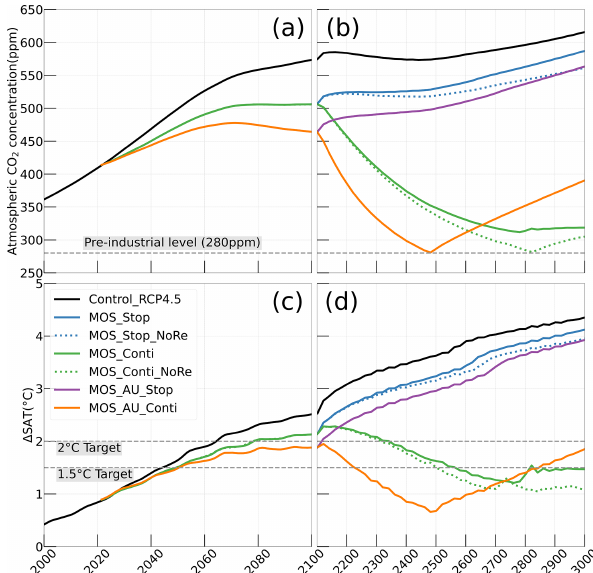
Figure 4. Simulations of ( a , b ) annual global mean atmospheric CO 2 concentration and ( c , d ) surface-averaged temperature relative to the pre-industrial (average of year 1850 to year 1900) level of 13.18 ◦ C ( (cid:49) SAT). Under RCP 4.5 scenario, MOS reaches the 2 ◦ C target in conjunction with AU, while the 1.5 ◦ C cannot be met in all MOS simulations. Note that MOS is terminated whenever pre- industrial concentrations of atmospheric CO 2 are reached, as seen for MOS_AU_Conti (solid orange) and MOS_Conti_NoRe (dotted blue) in ( b , d ). Both atmospheric CO 2 and (cid:49) SAT remain lower than control after MOS